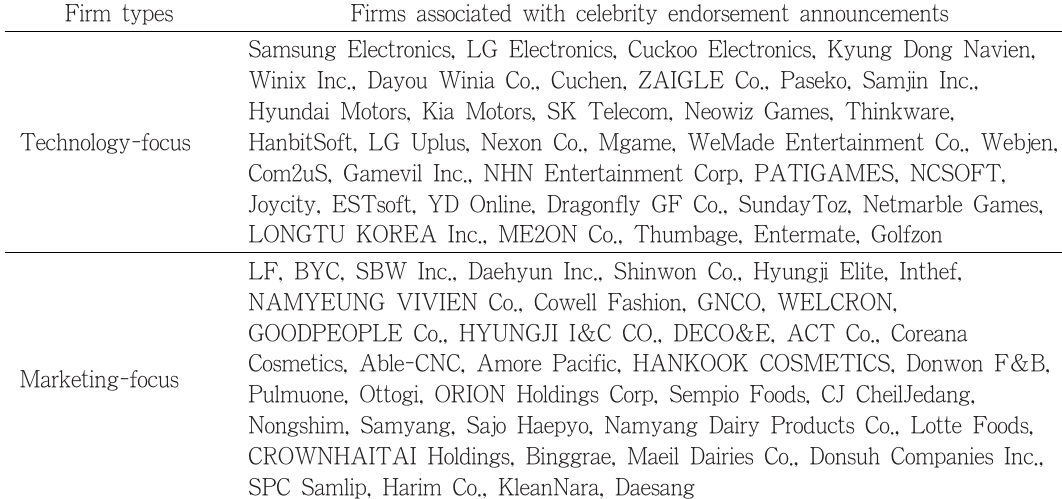
<Table 2> Types of Firms and Firms with a Celebrity Endorsement Contract